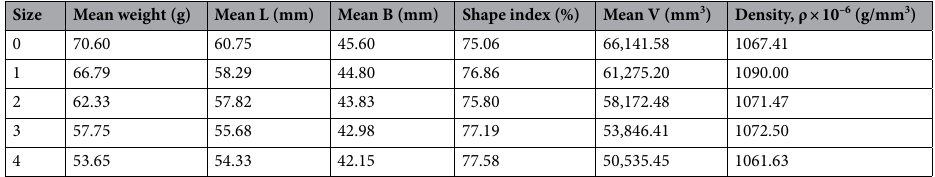
Table 3. The egg size and physical properties of the eggs examined at the highest egg freshness.